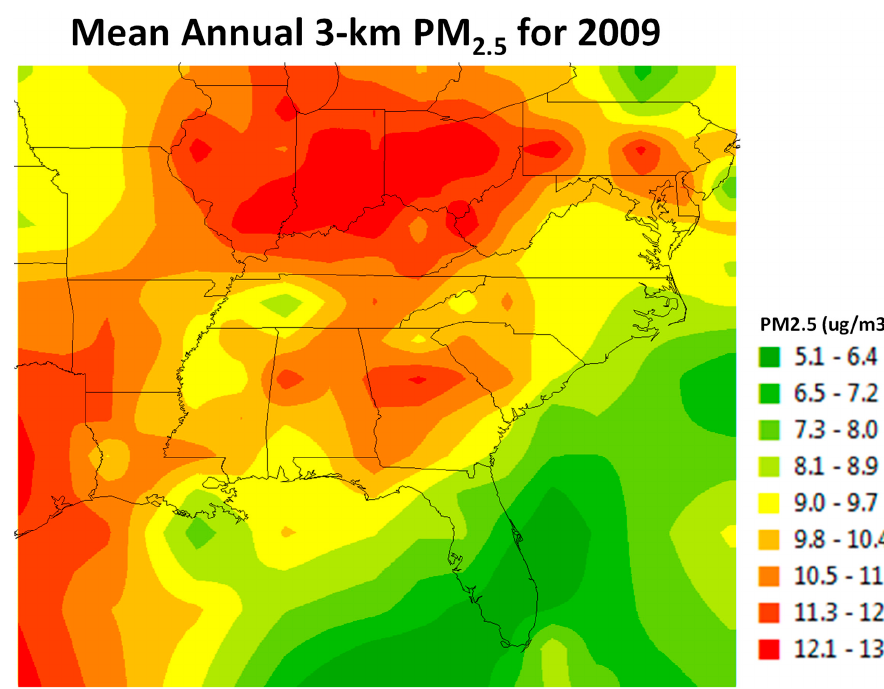
Figure 1. Southern Community Cohort Study and Average Annual PM 2.5 Exposures, 2009.